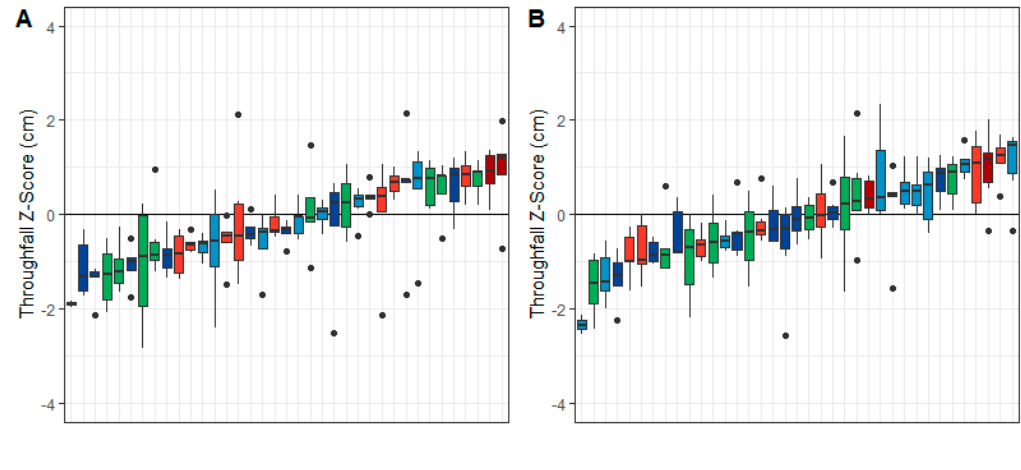
Figure 6. Rank of midstory throughfall gauges by species and median z-score in the ( A ) leaf-off and ( B ) leaf-on canopy phases. Species codes: ACRU = red maple, ULAL = winged elm, CATO = mockernut hickory, QUFA = southern red oak, QUAL = white oak.